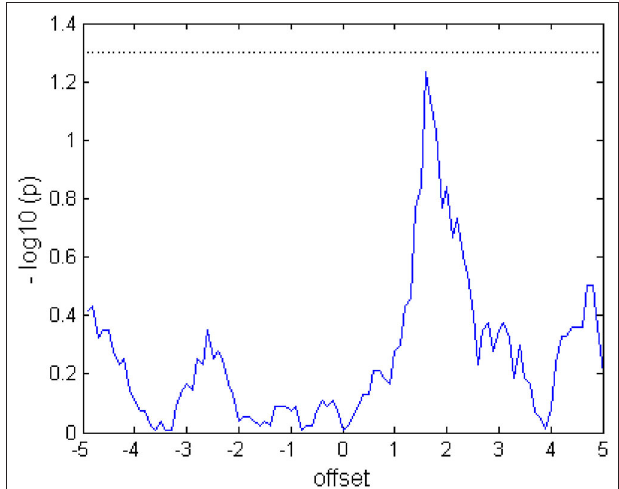
FIGURE 7 | Comparing the classification accuracy (CA) between tasks. When the graph exceeds the dotted line at 1.3 (log10(p) after Wilcoxon signed rank test), the CA of the two tasks would differ at a significance level of p < 0.05. The values were calculated from the average over subjects and